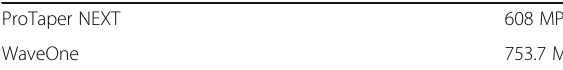
Table 3 The maximum von Mises stress during torsion